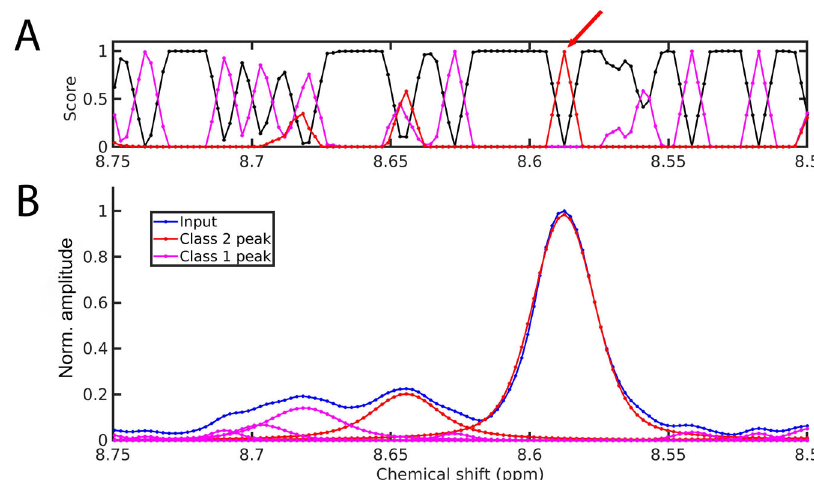
Fig. 3 Peak prediction by DEEP Picker for K-Ras 15 N – 1 H HSQC for part of a cross-section along the direct 1 H dimension. A Prediction score of Class 2 peaks (red), Class 1 peaks (magenta), and Class 0 non-peaks (black) from the output classi fi er layer after a 3-point moving average. The class with the highest score is the class assigned to a given data point after non-maximal suppression (see text). B Input spectrum (blue) together with reconstructed individual Class 2 peaks (red) and Class 1 peaks